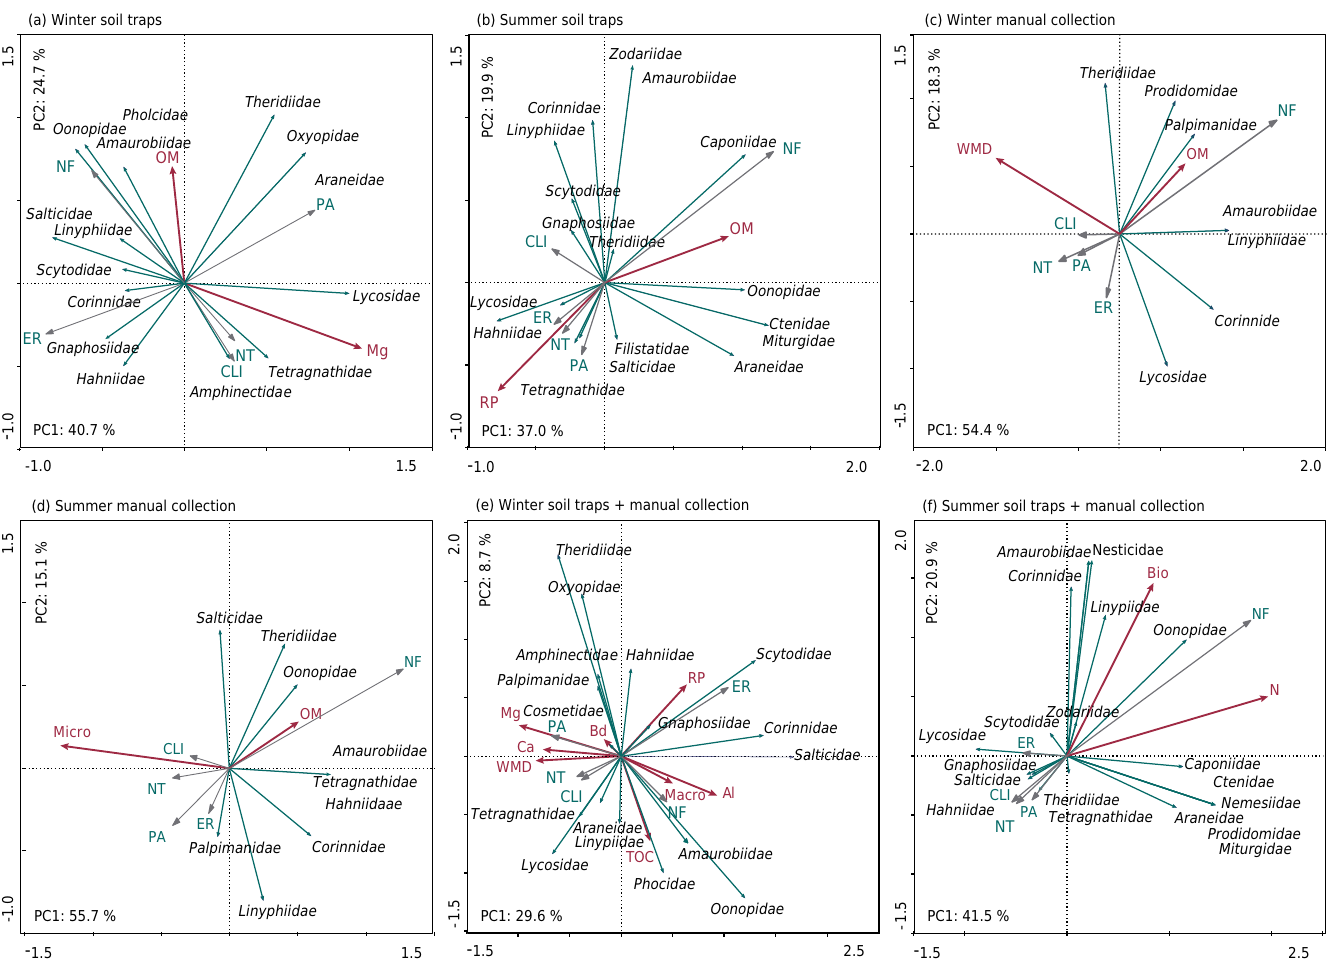
Figure 2. Principal component analysis (PCA) for spider families (in italics) and environmental variables (in red) in native forest systems (NF), eucalyptus reforestation (ER), pasture (PA), crop-livestock integration (CLI), and no-tillage annual crops (NT) in western Santa Catarina in two seasons: winter and summer. Two methods of collection (traps and manual collection). OM = organic matter; Mg = magnesium; RP = resistance to root penetration; WMD = weighted mean diameter; Micro = microporosity; Macro = macroporosity; COT = total organic carbon; Al = aluminum; Bd = soil bulk density; Ca = calcium; Bio = biopores; N = nitrogen; PC1 = main component 1; PC2 = main component